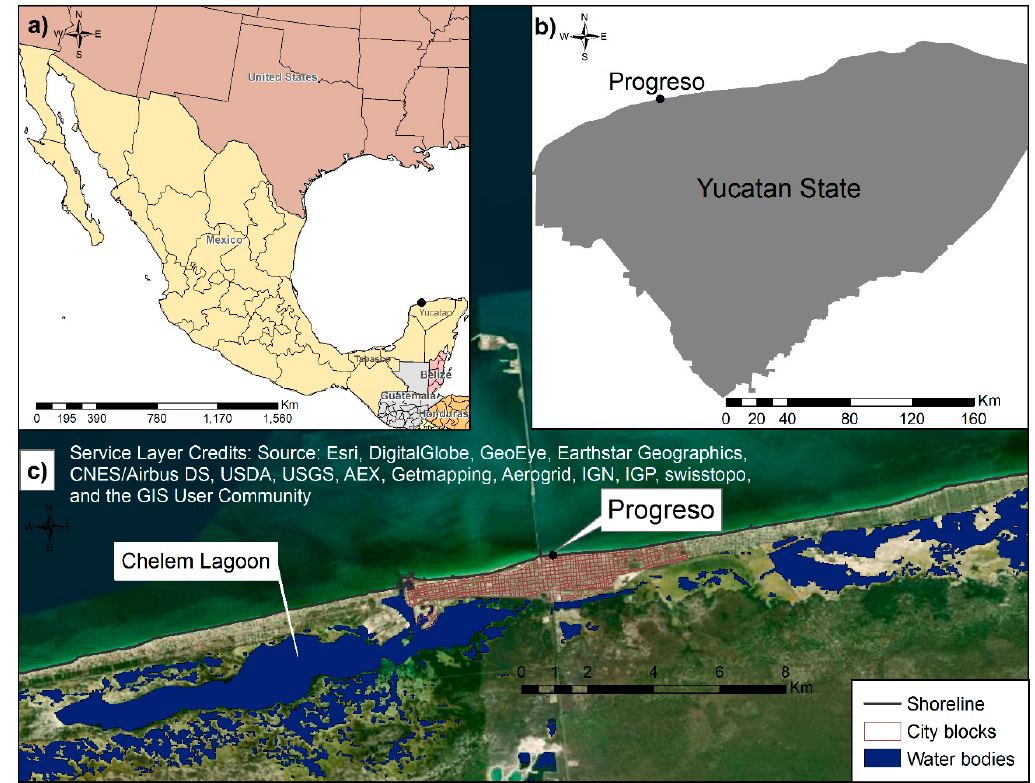
Figure 1. Study area location in ( a ) Mexico, and in the ( b ) Yucatan state, ( c ) Progreso and Chelem lagoon.